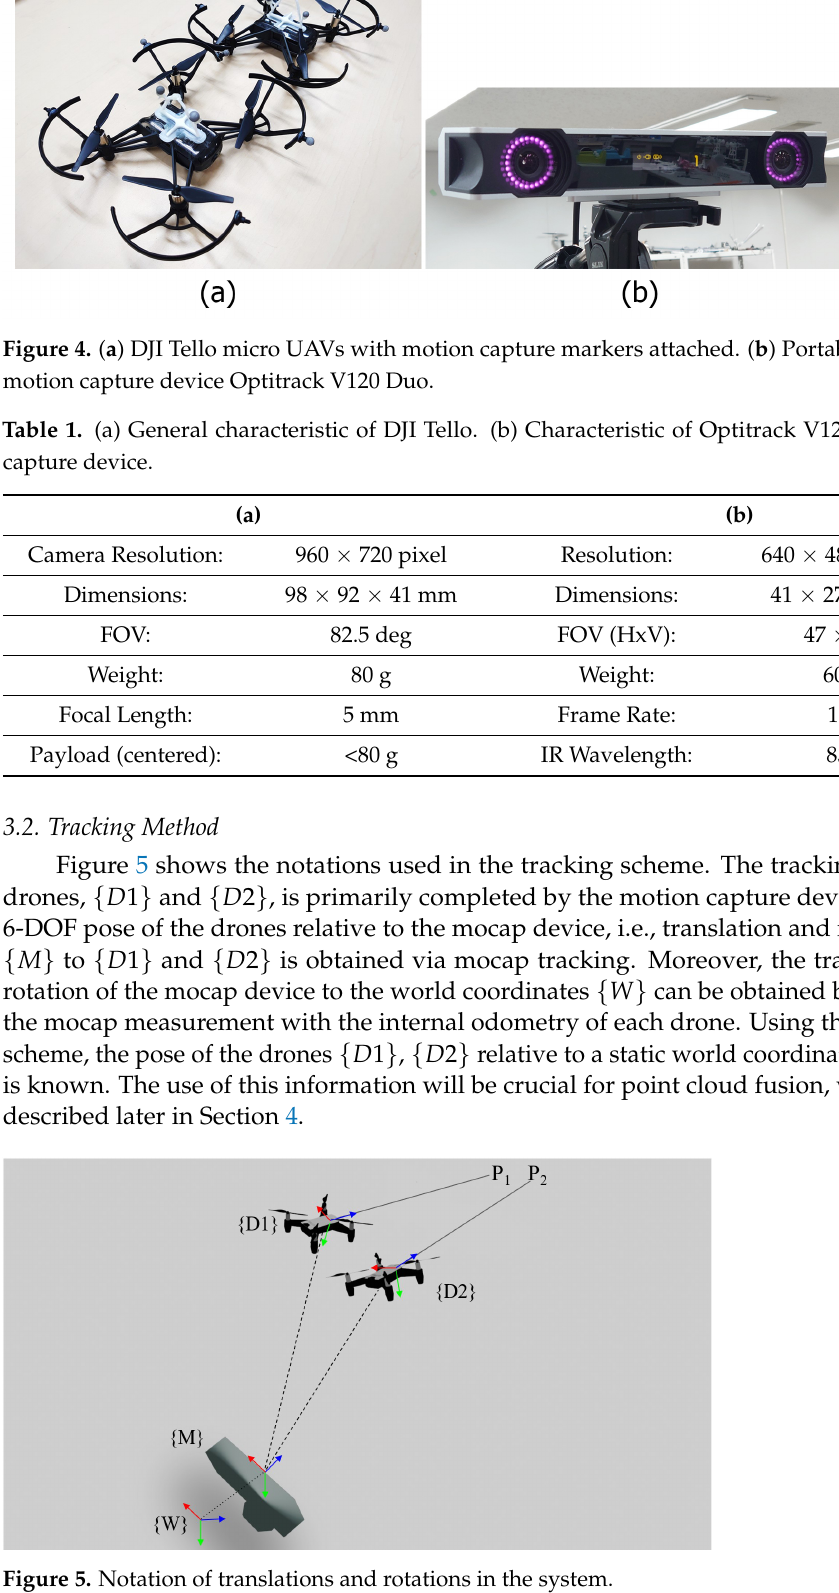
Figure 5. Notation of translations and rotations in the